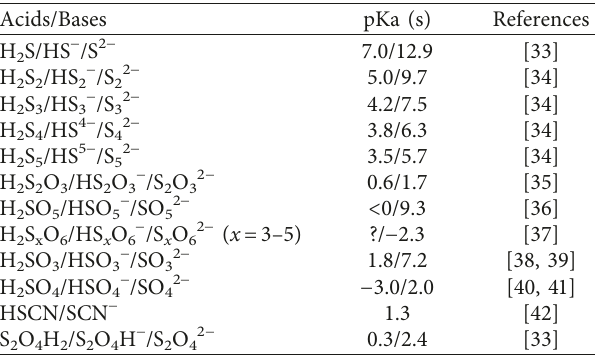
Table 1: pKa of frequently encountered sulfur species (in water at 25 °